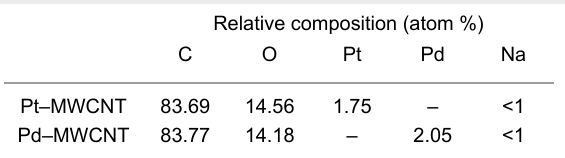
composition determined by this technique indicated that the amounts of Pt or Pd were near 2 atom % (see Table 1).